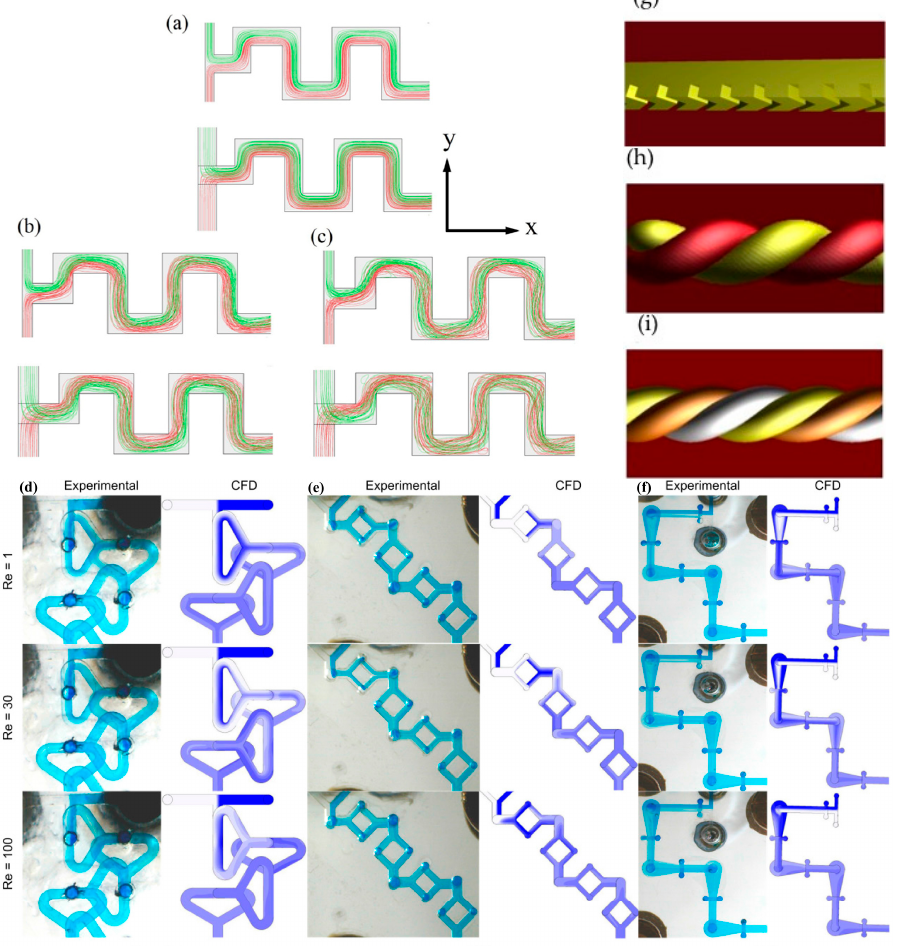
Figure 1. Various mixing geometries. ( a – c ) Two flows ( green and red ) in two different sizes of serpentine type of microchannels at Re = 0.1 ( a ), 30 ( b ) and 90 ( c ) (with permission from Shakhawat Hossain [10]). Other geometries are presented in ( d ) the Teardrop, ( e ) the Y–Y and ( f ) the H–C mixing geometries at Re = 1 ( top ), 30 ( middle ) and 100 ( bottom ). The left column of each geometry represents an experiment, where as on the right the images taken from computer simulations (with permission from Vladimir Viktorov [11]). ( g ) The herringbone mixer, ( h ) a double helix and ( i ) a triple helix mixer. The latter two are part of the work presented in this manuscript.